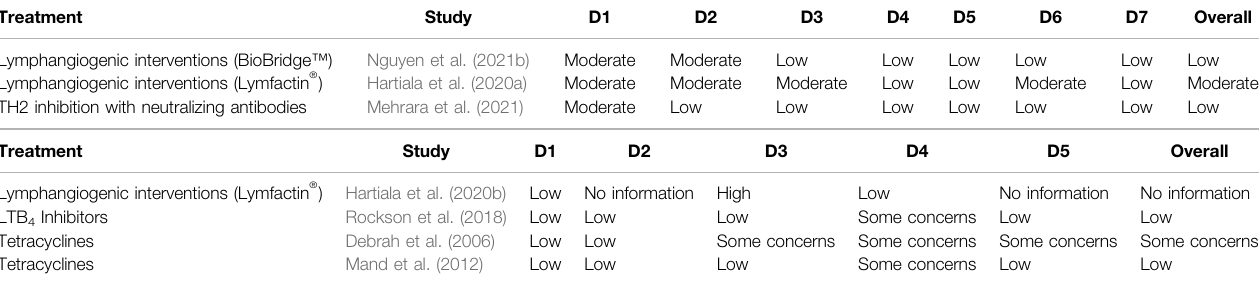
TABLE 1 | Summary of Risk of Bias among Randomized (ROB2 tool) and Non-randomized Trials (ROBINS-I tool). A. Risk of Bias for Non-randomized Trials.